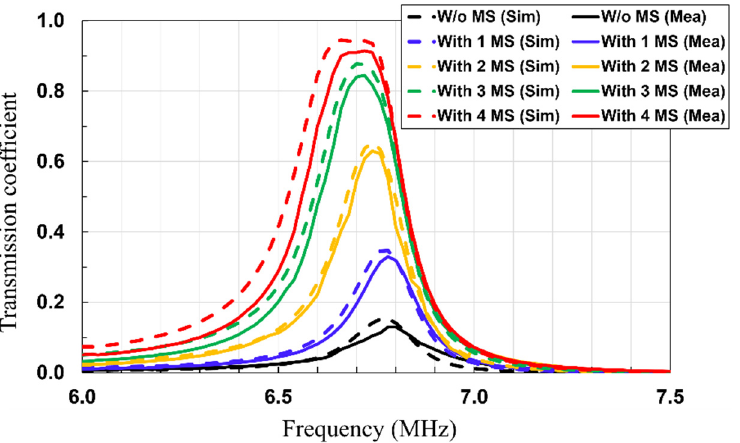
Figure 9. Simulated and measured transmission coefficient (S 21 ) of the rollable MS-based WPT sys- tem without and with MS screens at a PTD of 60 cm.